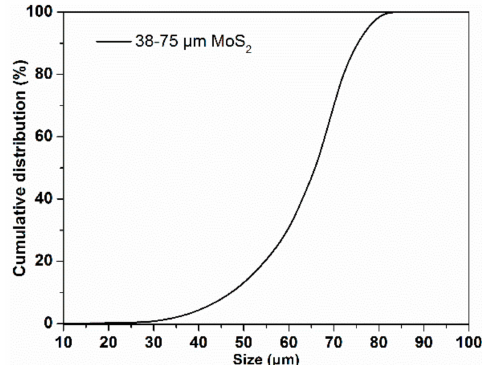
Figure 2. Cumulative size distribution of MoS